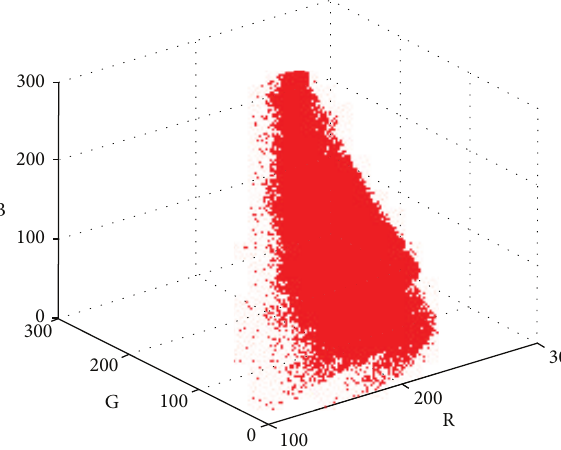
Figure 6: Sample pixels used for GMM